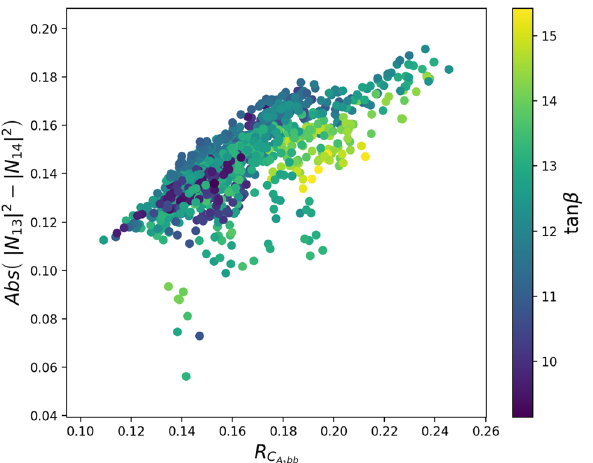
Fig. 4 GCE-samples plotted on the plane of σ SI color denoting the reduced coupling R C (red) line represents σ SI 10 − 41 cm 2 ) limit from XENON1T (Pandax-II) at 90% confidence level (cid:10) 62 near m (cid:2) χ 0 1